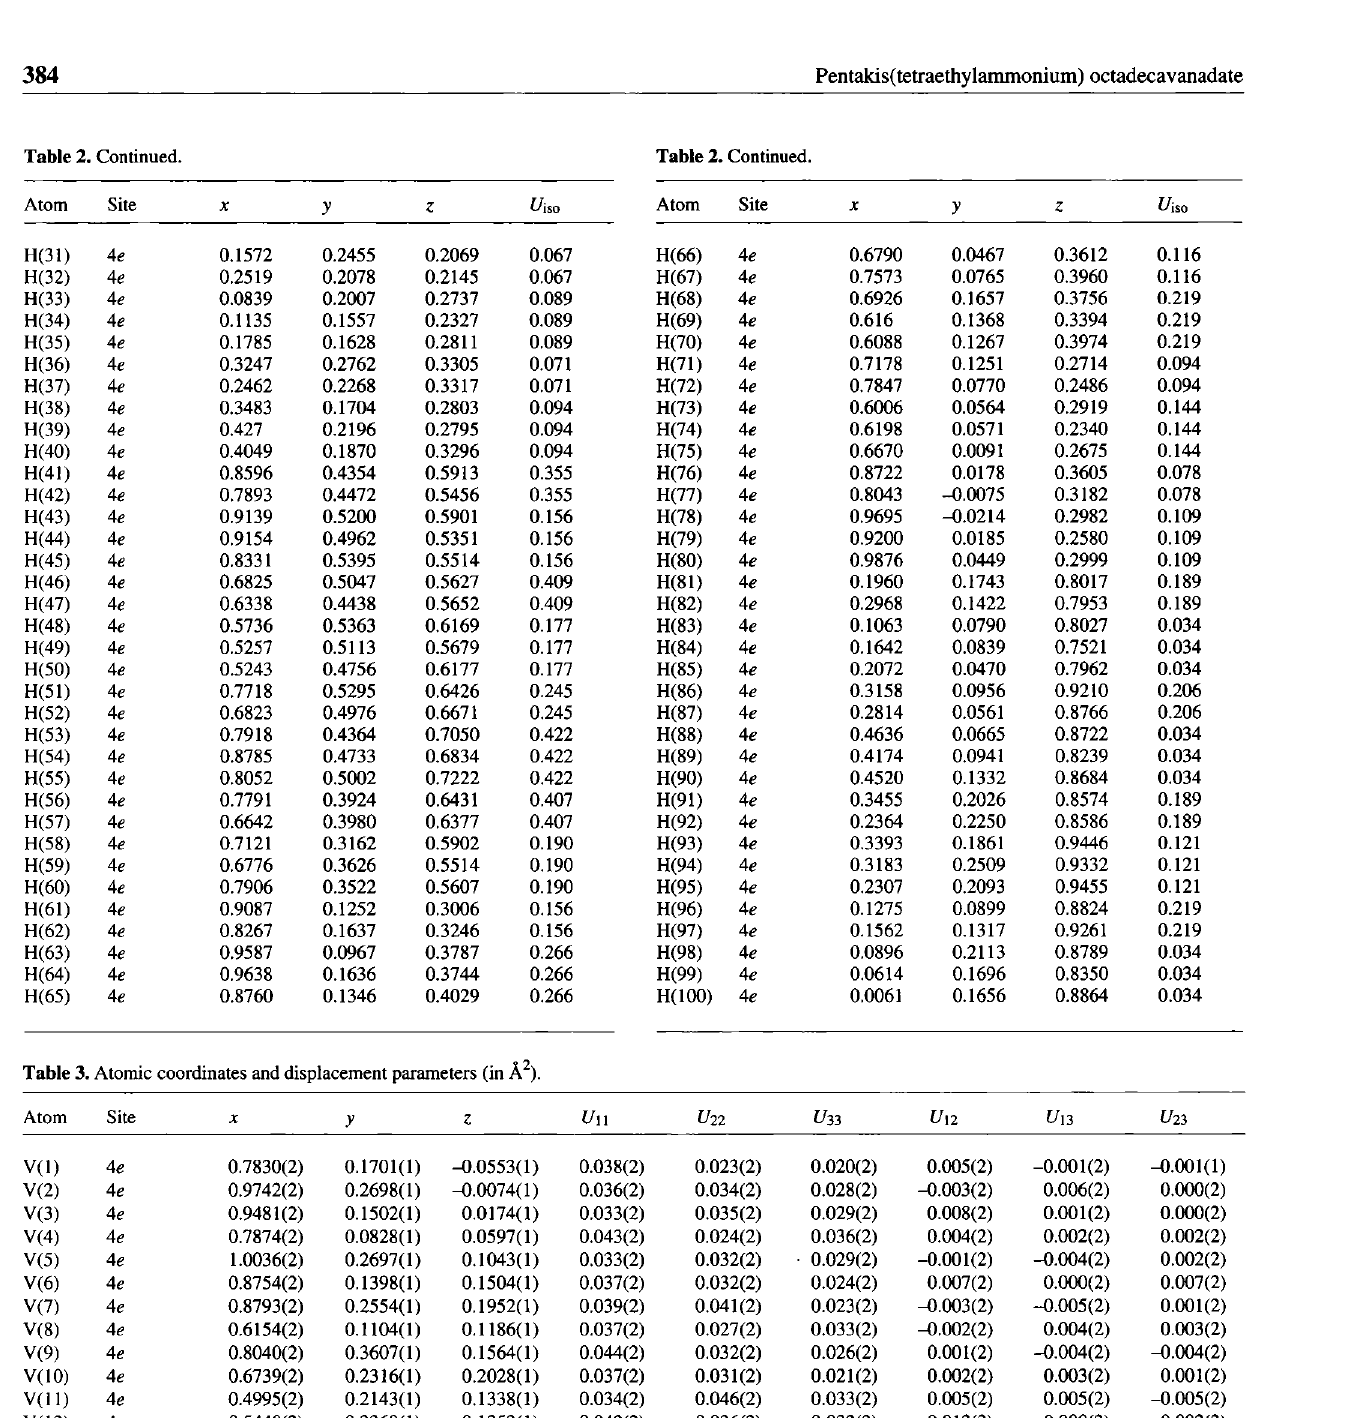
Table 3. Atomic coordinates and displacement parameters (in Â 2